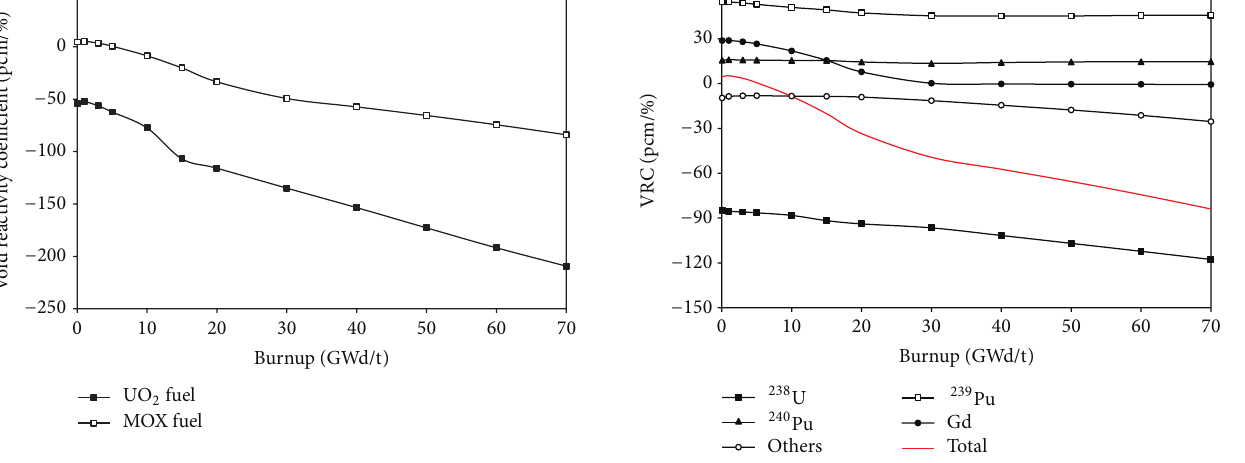
Figure 6: Decomposition of VRC values for separate isotopes in MOX.